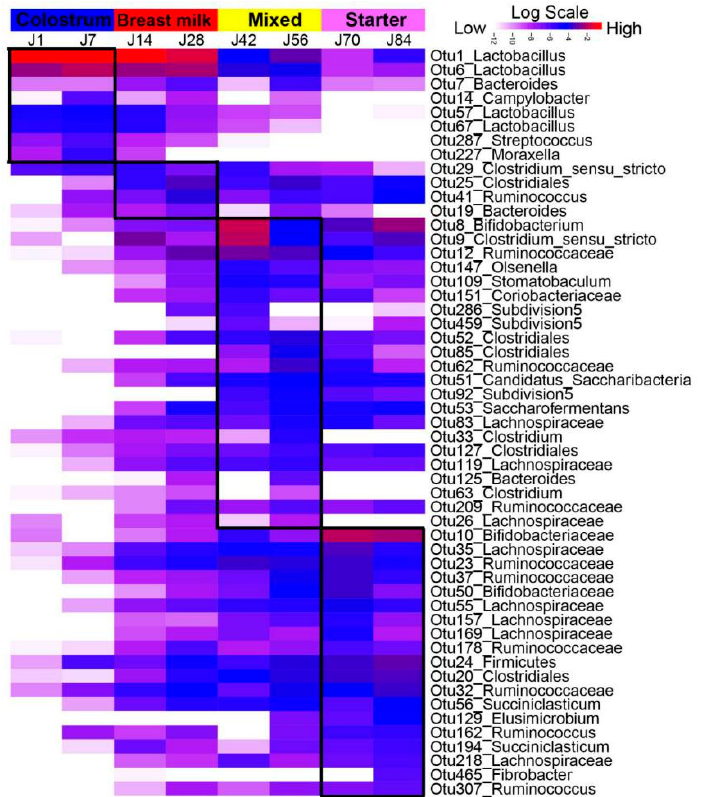
Figure 4. The jejunum stage-associated bacteria identified by linear discriminant analysis (LDA) effect size (LEfSe) analysis. The heat map shows the average relative abundances of ages on a log scale. The Log-scaled relative abundance heatmap of stage-related OTUs screened by Lefse (LDA > 2), in the jejunum microflora. The color of cells from white to red corresponds to the relative abundance of OTUs from low to high. The growth phases of colostrum (d1 and d7), breast milk (d14 and d28), mixed feeding (d42 and d56) and starter feeding stages (d70 and d84) were labeled with different colors. J1 = jejunum d1; others can be deduced by analogy.